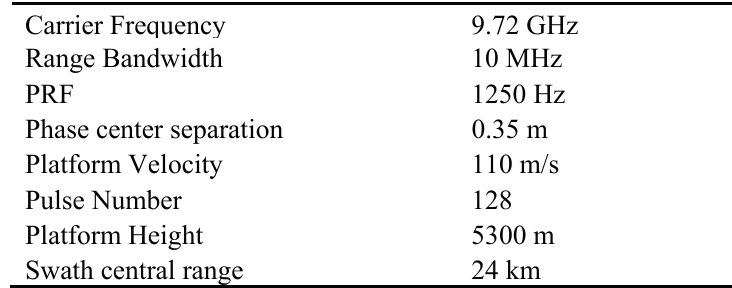
Table 2. System Parameters for synthetic aperture radar (SAR)-ground moving target indication (GMTI) experiment.